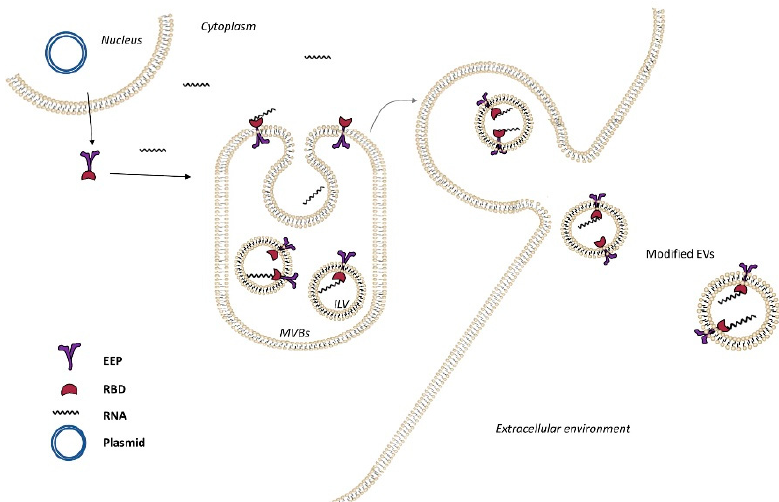
Figure 2. Active loading of cargo RNA into extracellular vesicles (EVs) via TAMEL. TAMEL EV-loading protein comprises an EV-enriched protein (EEP, violet) fused to an RNA-binding domain (RBD, red), which localizes to EVs. Actively loaded RNA contains a motif that binds to the RBD, resulting in enhanced loading into EVs.